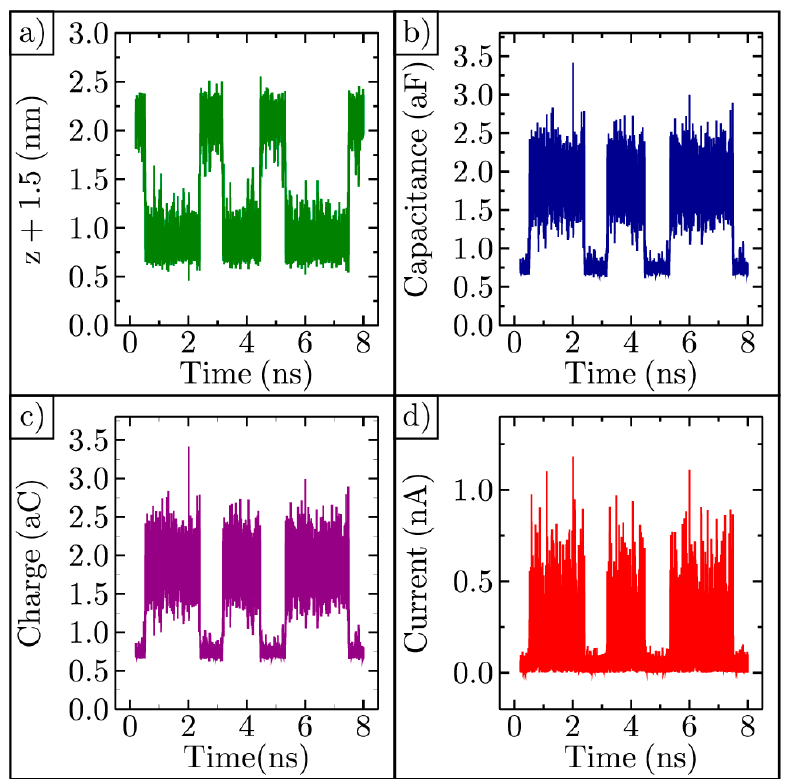
Figure 9. Graphene ripple near a fixed electrode: ( a ) The distance between the electrode and the ripple; ( b ) Capacitance of the graphene-electrode capacitor; ( c ) Charge on the graphene capacitor; ( d ) Rectified portion of the alternating current flowing in the circuit.